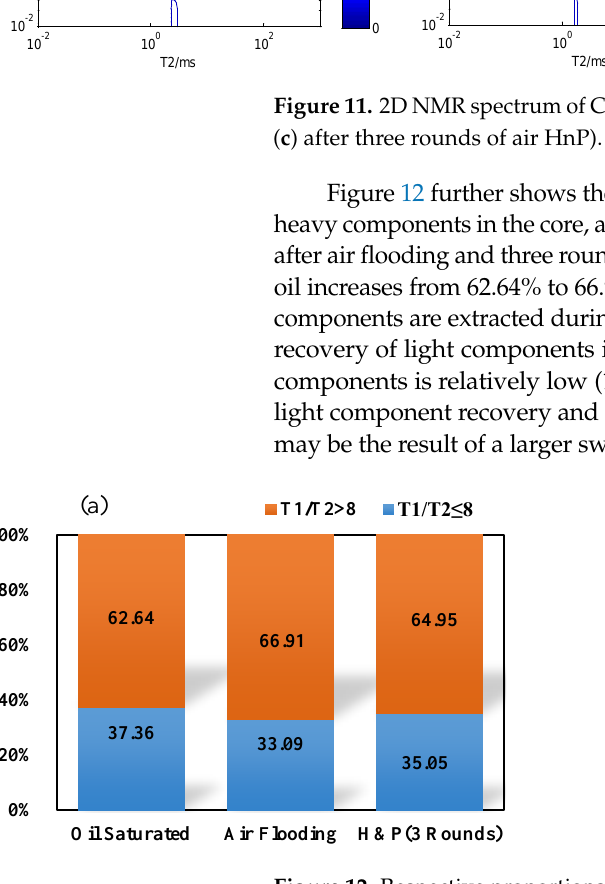
Figure 12. Respective proportions of light and heavy components ( a ) and the corresponding recovery factors ( b ).